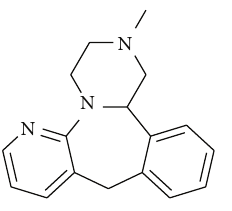
Figure 1: Chemical structure of mirtazapine